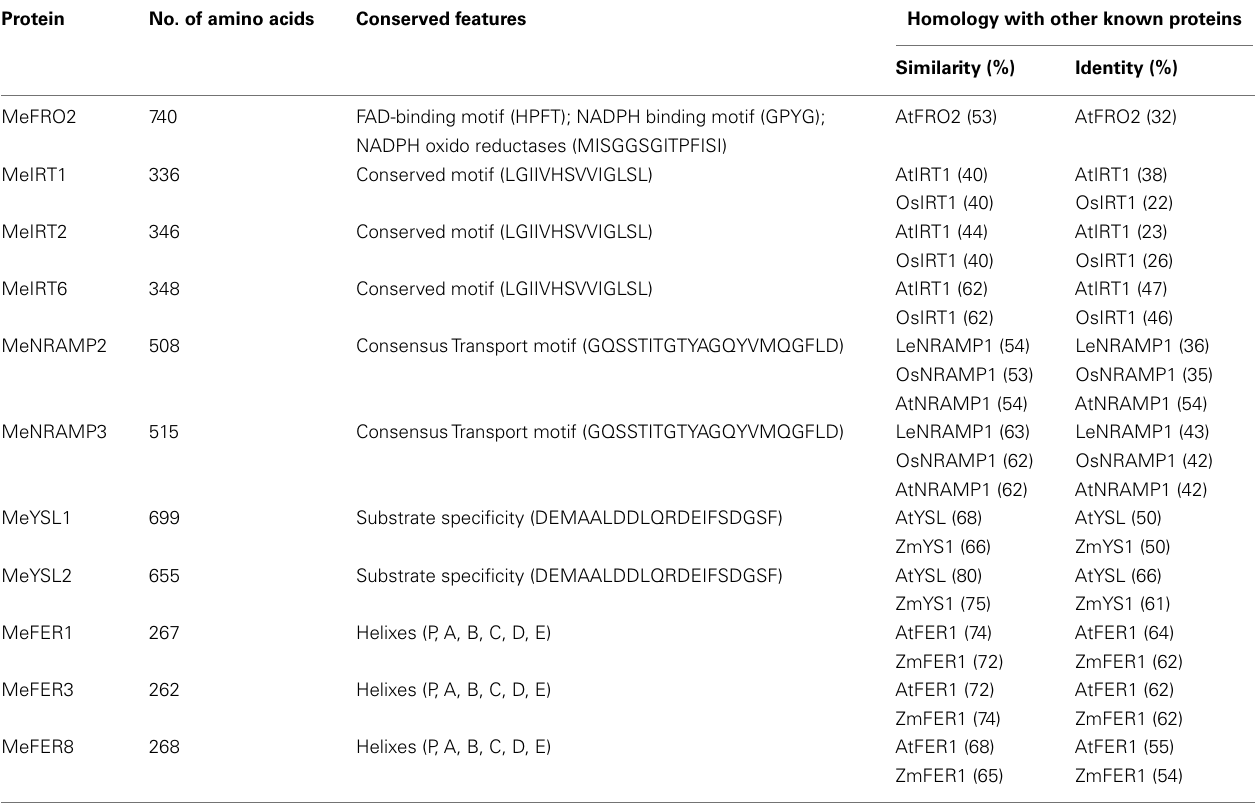
Table 3 | Representative metal homeostasis genes in cassava.